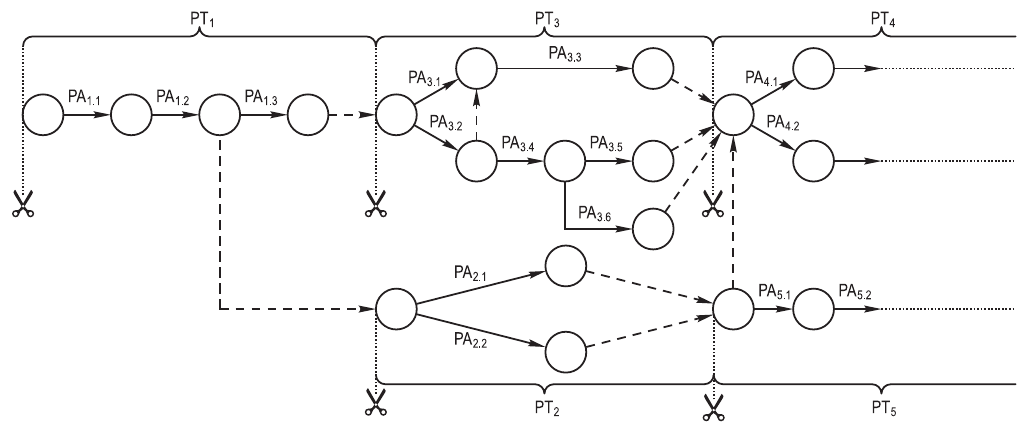
Fig 4. “Cutting” fragments from TNM of potential actions to implement strategic